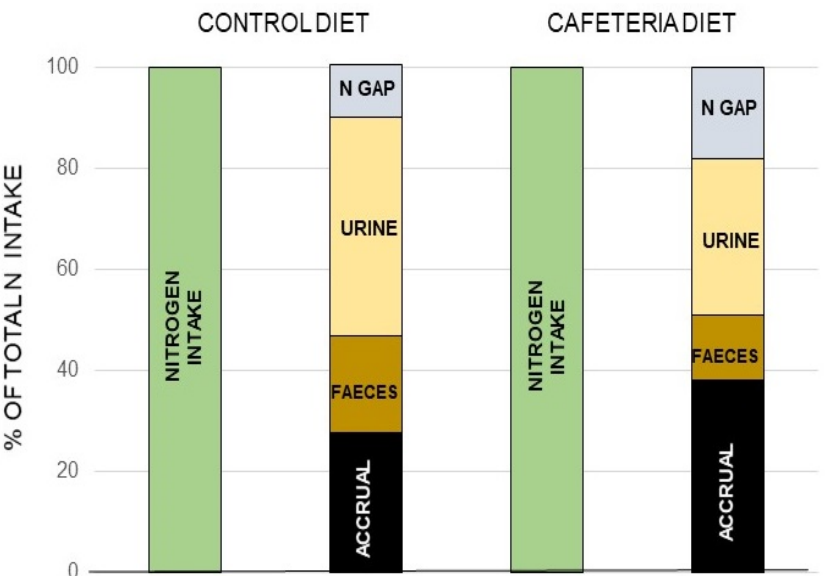
Figure 7. The nitrogen “gap: in rats. A “nitrogen gap” was found when analyzing all the components of the nitrogen balance in young rats: i.e., the N ingested, that excreted by urine and feces as well as the total N accrued, thus proving the existence of a sizeable part of the N excreted not as urea, or through the other possible ways and means shown in Box 1. Different complete (measuring both sides of the N balance equation) studies repeated these findings, dependent on diet, and with a magnitude (in rodents at least) in the range of 10–30% of all nitrogen excreted. Redrawn with data from Esteve et al. [130].